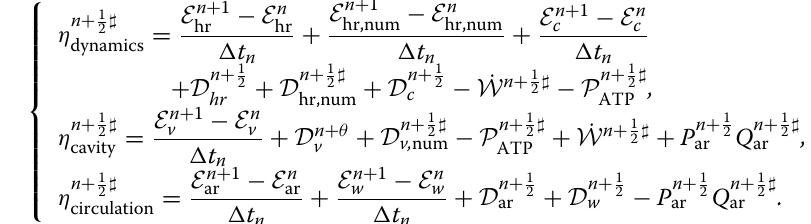
Numerical validation of the energy balance behind the coupling